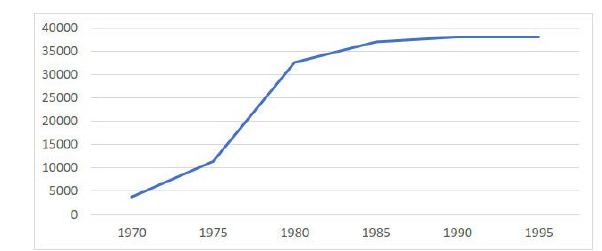
Figure 2. Increase in size of the bean collection introduced into the CIAT